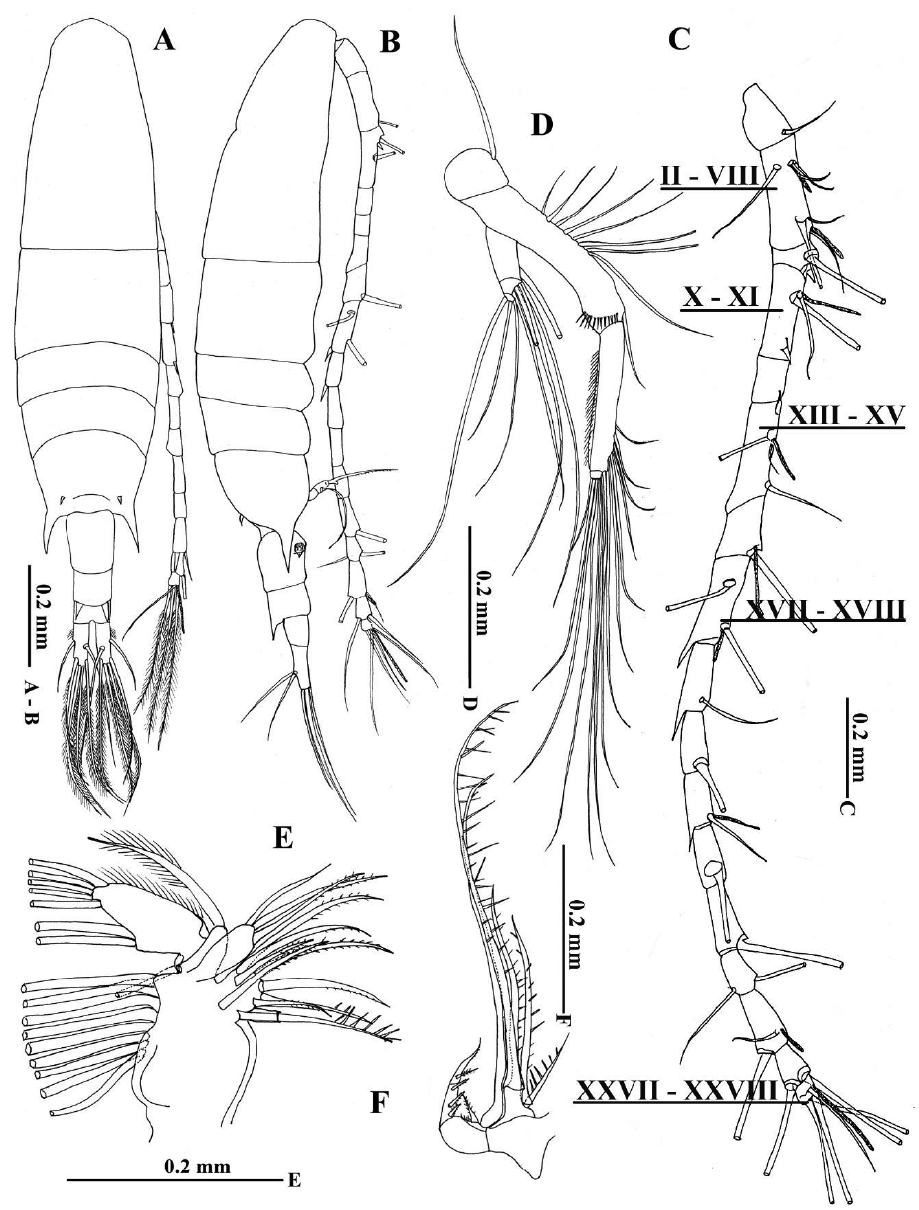
Figure 2. Acartia ( Odontacartia ) edentata sp. n. female (holotype) A Habitus, dorsal view B Habitus, lateral view C Antennule, Roman numerals denote segment numbers D Antenna E Maxilla F Maxilliped. Antenna (Fig. 2D) coxa with single seta; basis fused to elongated first endopodal segment forming allobasis with eight setae on outer medial margin, and single lateral seta and transverse row of small spinules terminally; second segment with eight